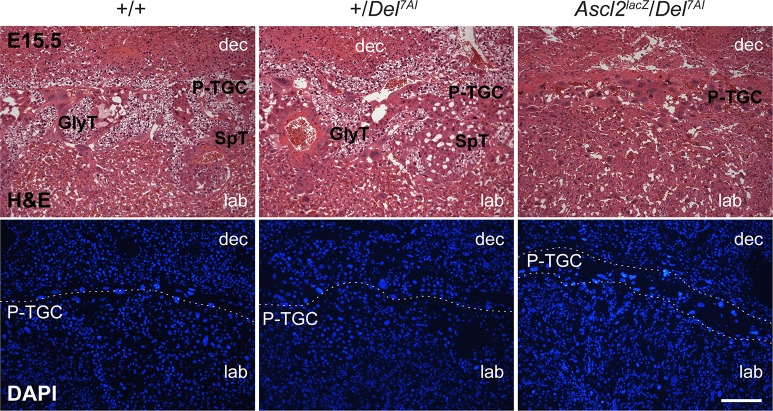
Hyperplastic parietal trophoblast giant cell layer in Ascl2lacZ/Del7AI placentae at E15.5.Heamatoxylin and eosin (H&E, top) and DAPI (bottom) staining of wild-type, +/Del7AI and rescued Ascl2lacZ/Del7AI placental sections at E15.5. DAPI staining readily identifies the large polyploid nuclei of the cells stacked at the giant cell layer in the mutants. dec, decidua; P-TGC, parietal trophoblast giant cells; SpT, spongiotrophoblast cells; GlyT, glycogen trophoblast cells; lab, labyrinthine layer. Dashed lines indicate the P-TGC layer boundary. Scale bar: 0.5 mm.